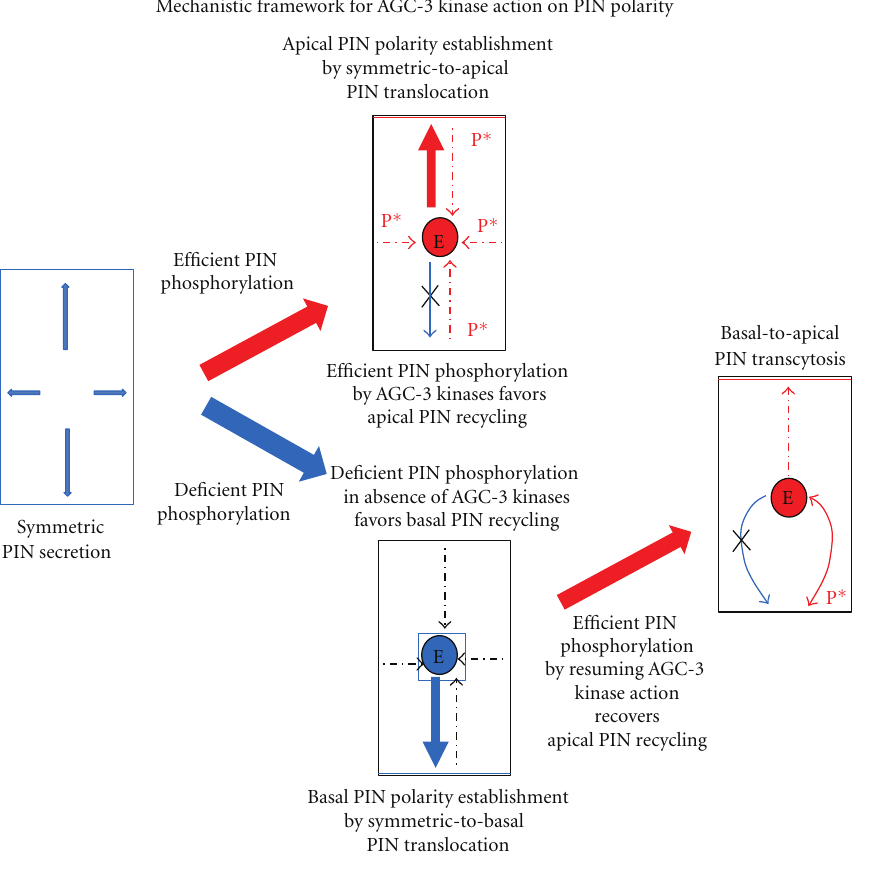
Figure 2: AGC-3 kinase-mediated phosphorylation status of PINs instructs directional PIN tra ffi cking during establishment, maintenance, and alteration of PIN polarity. Note that polar plant cells possess cell-side-specific polar recycling pathways and phosphorylation-based sorting of polar cargoes recruits them in to a specific recycling